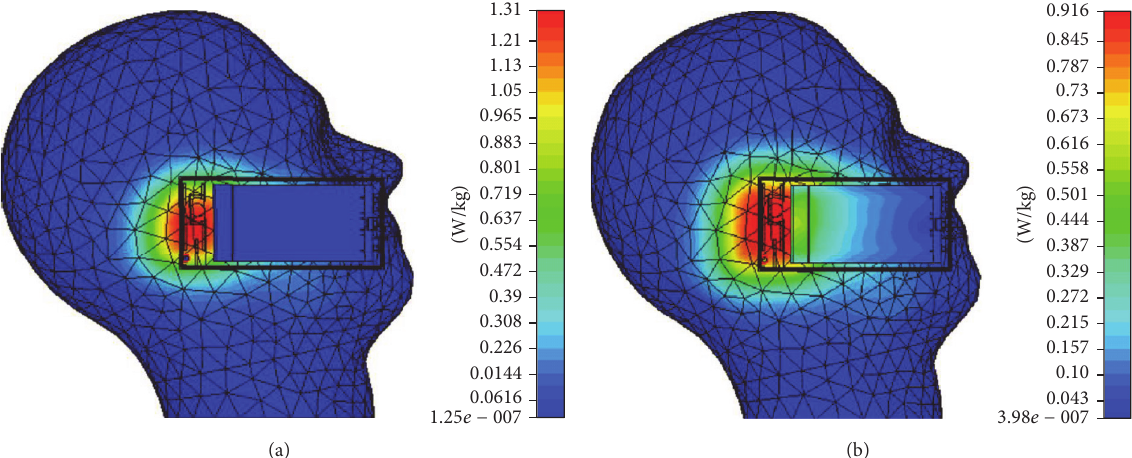
Figure 14: SAR distribution at 1870MHz: (a) average 1-g and (b) average 10-g.